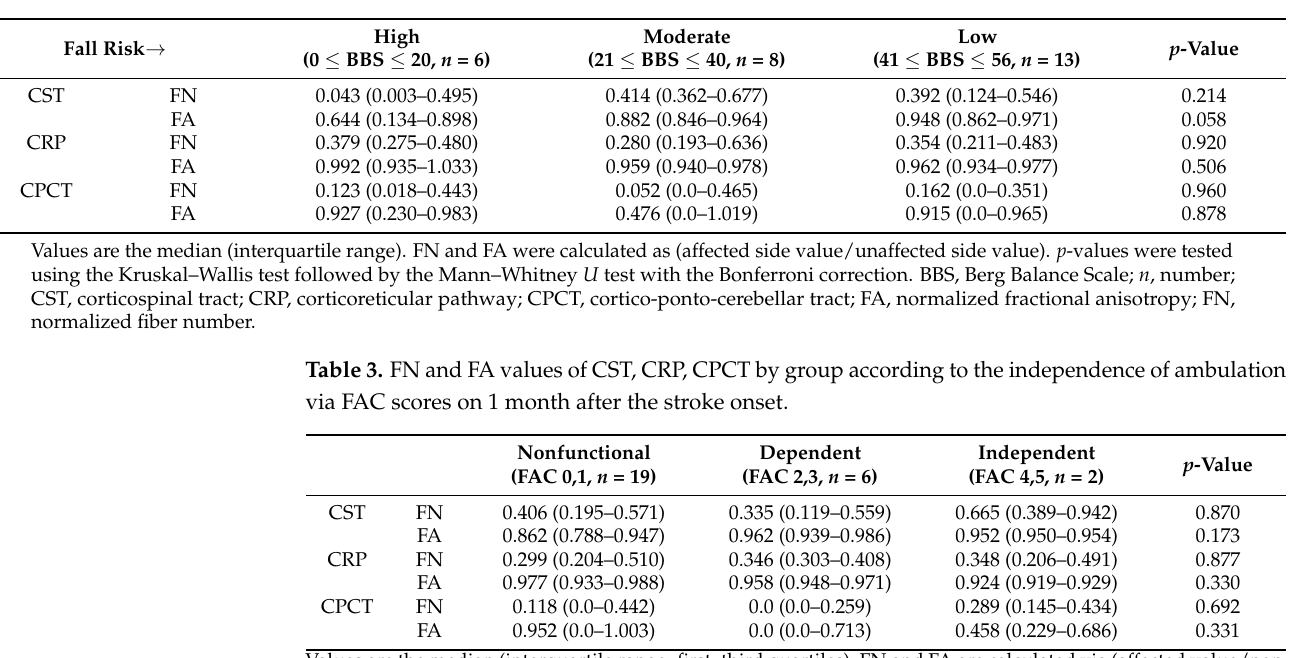
Table 2. FN and FA values for the CST, CRP, and CPCT by groups classified based on the BBS score 6 months after stroke onset.